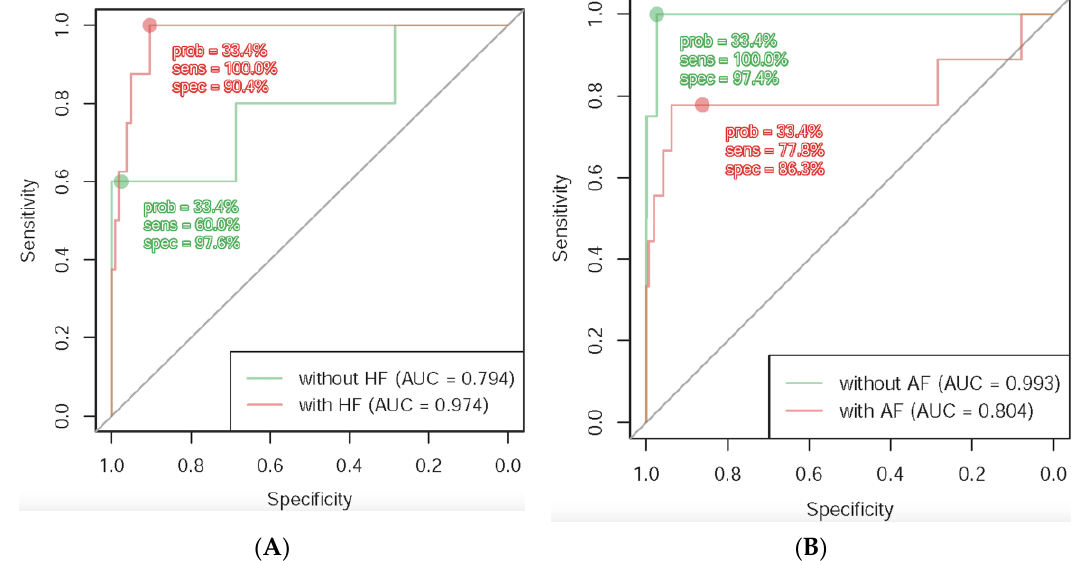
Figure 4. ROC curves under significant stratified variables. ( A ) Better prediction of the AI model may be noted with a larger AUC in patients known to have heart failure; ( B ) Worse prediction of the AI model with smaller AUC for patients with atrial fibrillation.